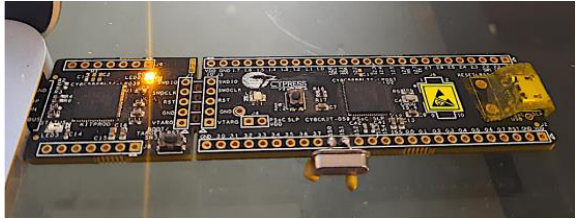
Figure 8. Cypress development USB stick used for performance testing.